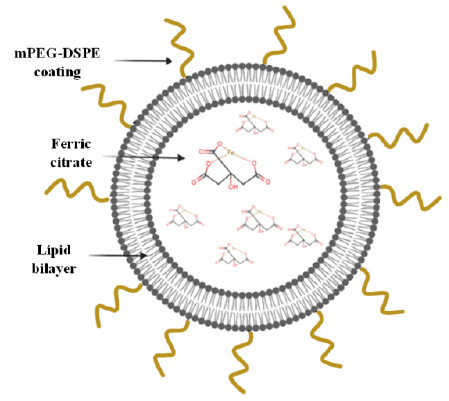
Figure 1. Schematic representation of the FC